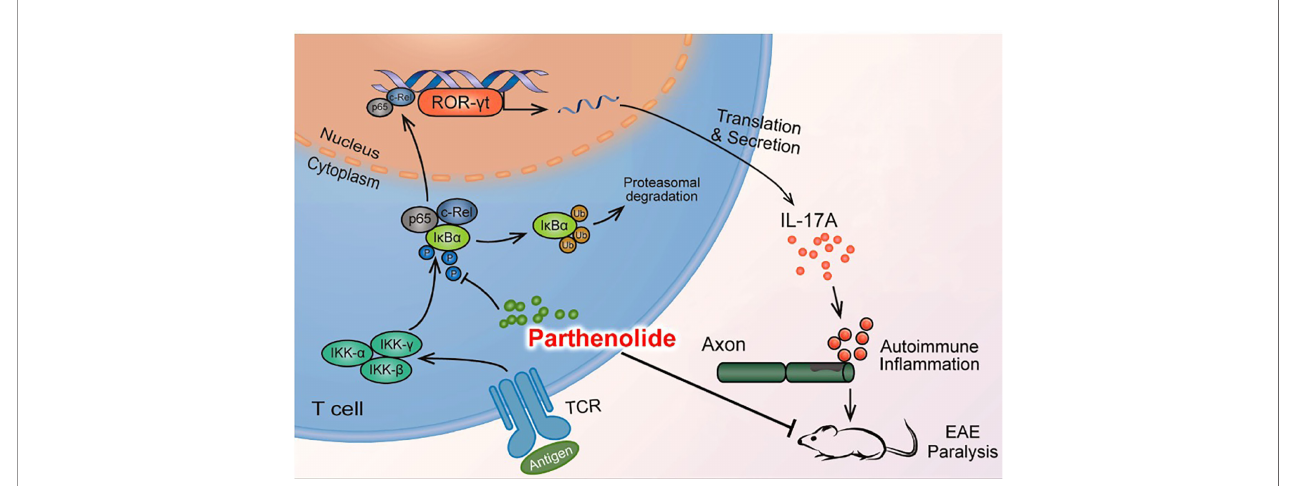
FIGURE 7 | Mode pattern for the effect of PTL on the NF- k B/ROR- g t